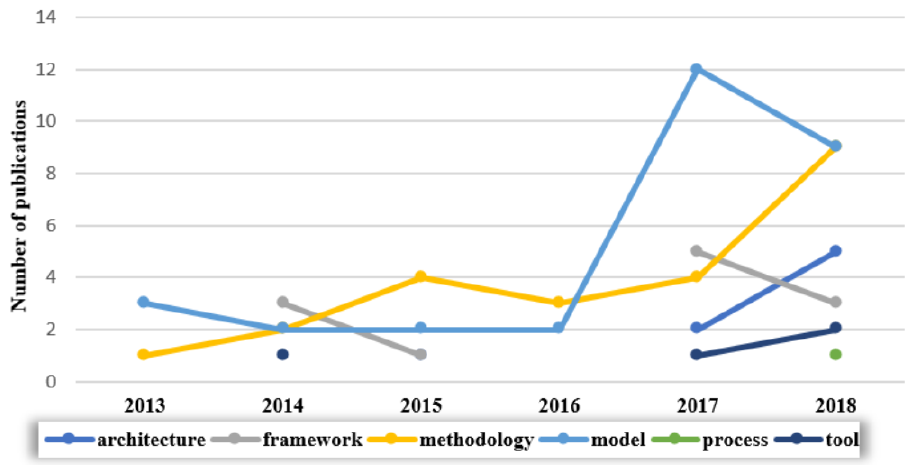
Figure 12. Trend in publication by contribution